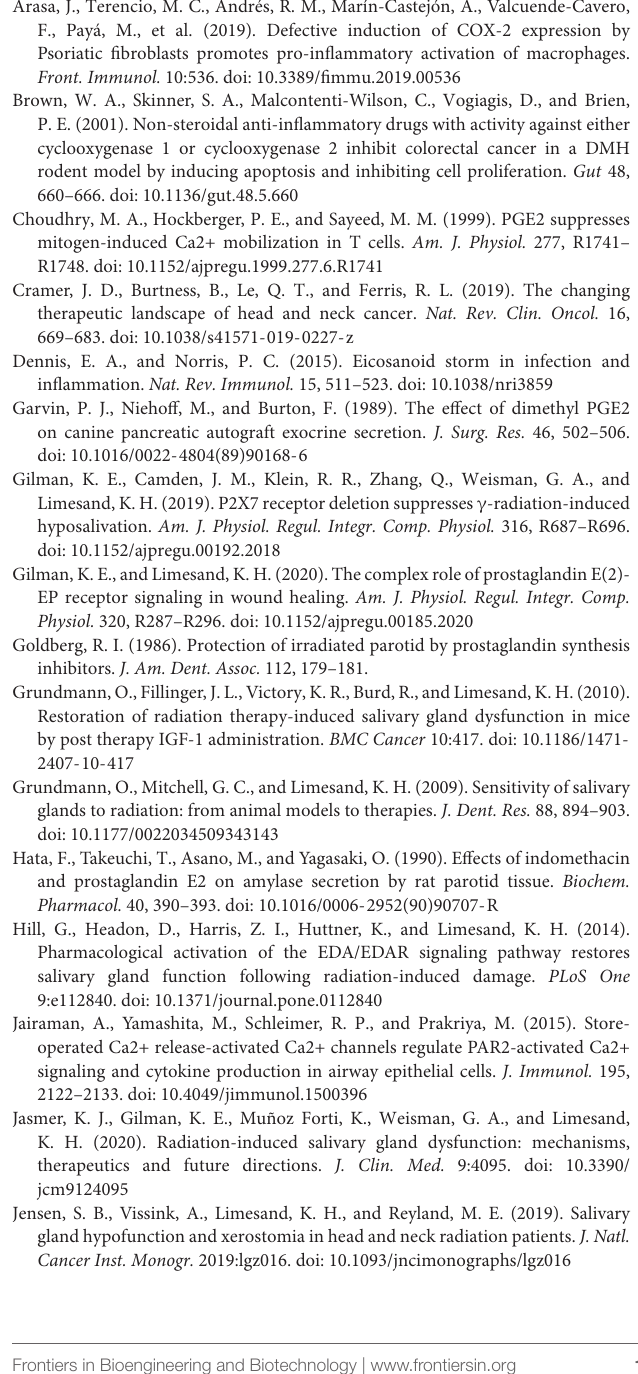
Supplementary Figure 2 | The effect of indomethacin treatment on AQP5 and MIST1 levels in irradiated parotid glands. (A–C) C57BL/6J mice were untreated (UT) or received 5 Gy ionizing radiation (IR) with intraperitoneal injections of vehicle (Veh, saline with 10% ethanol) or indomethacin (Indo, 1 mg/kg body weight) at days 3, 5, and 7 following IR and parotid glands were extracted at day 30. Immunoblots were generated from tissue lysates using anti-AQP5 or anti-MIST1 antibodies, and blots were stripped and re-probed for β -tubulin as a loading